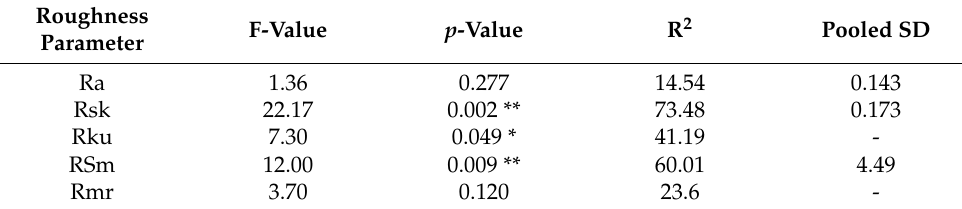
Table 5. One-way ANOVA (Fisher’s) comparison of measured parameters of Surface A and B.